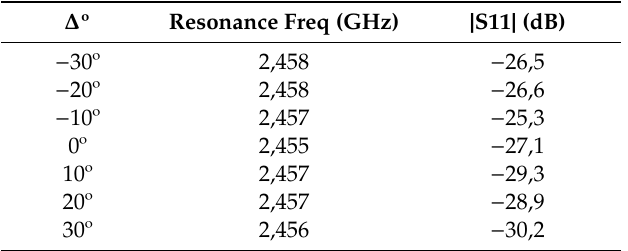
Figure 8. S11 parameter measurement results (WT14 substrate prototype), as a function of angular deflection of the substrate, within the − 30 ◦ to + 30 ◦ range, with respect to the horizontal plane containing the antenna. Table 2. Matching performance as a function of angular